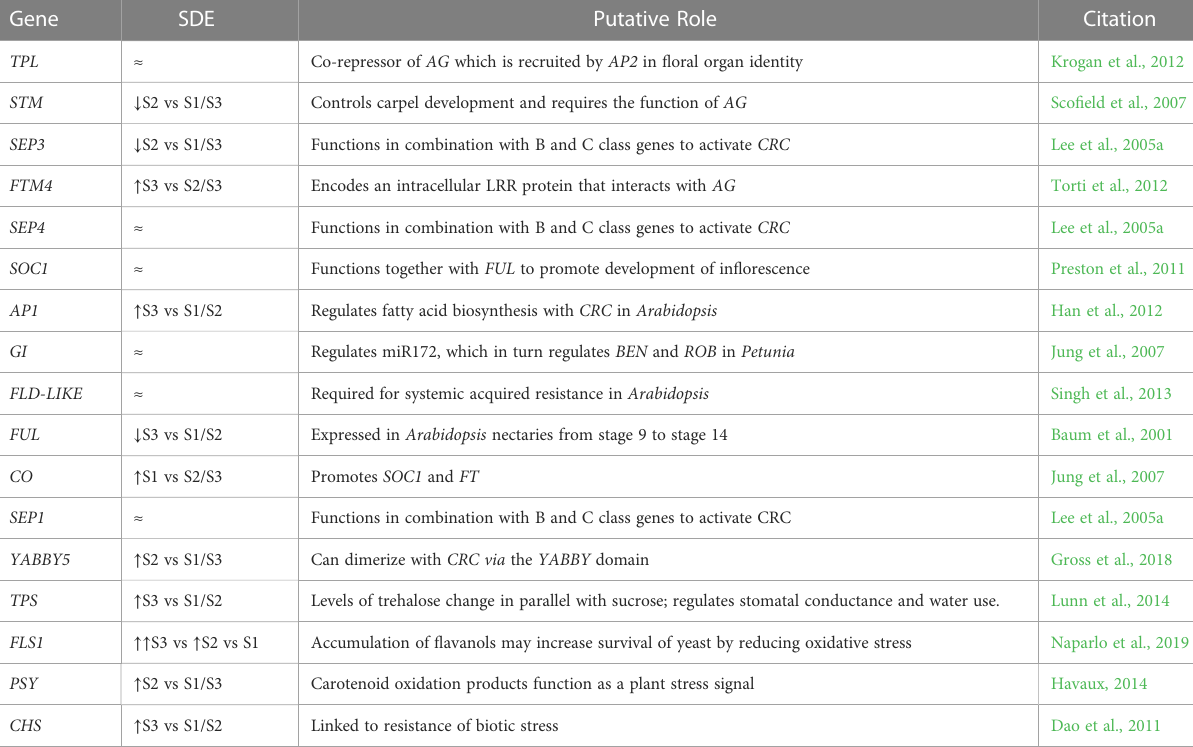
SDE, Signi fi cant Differential Expression with arrows representing either up or down regulation of expression between developmental stages ( ≈ indicates no SDE). S1, pre-anthetic nectary; S2, anthetic nectary; S3, post-anthetic nectary.